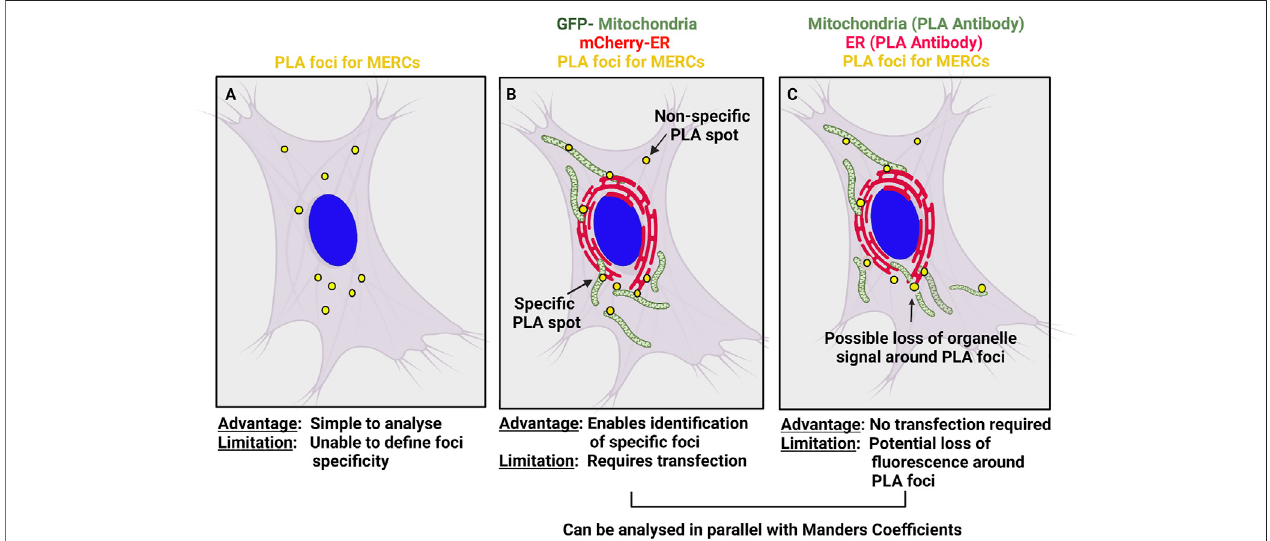
FIGURE 1 | Analysis of PLA foci along with organelle markers. (A) Classical analysis of PLA foci where colocalization with organelle markers is not taken into consideration. (B – C) Alternatively, ER and mitochondria can be co-stained with PLA foci to further validate that PLA foci are localized at MERCS. This can be achieved using fl uorescent-tagged proteins or stains (B) or fl uorescent secondary antibodies recognizing the primary PLA antibodies.